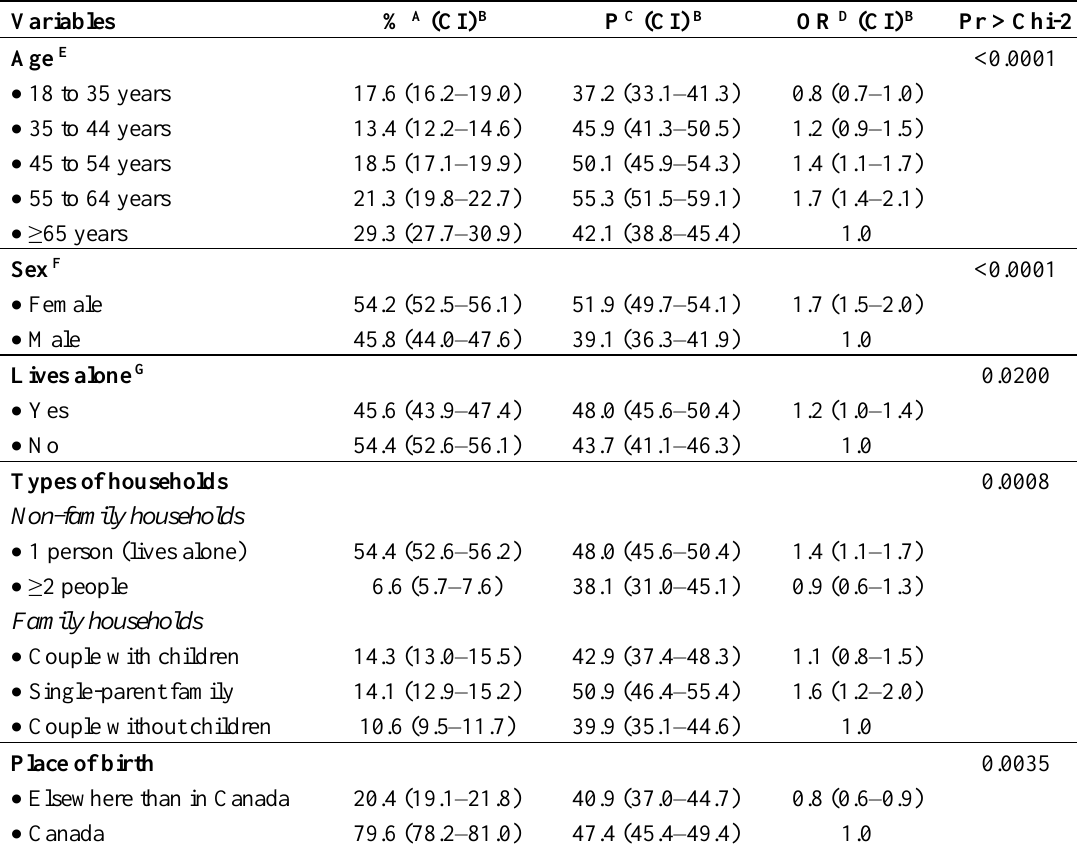
Table 1. Prevalence of reported adverse health impacts, very hot and humid summer conditions, based on sociodemographic and sociocultural